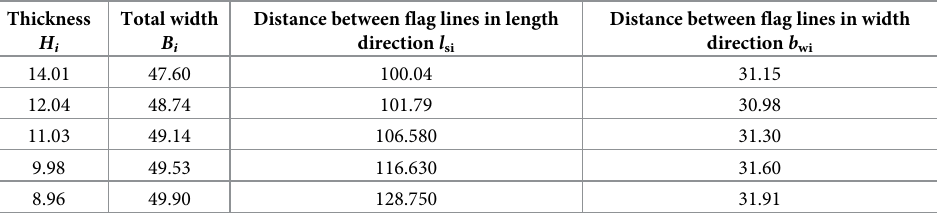
Table 1. Original data of the flat rolling experiments of the CORFT (mm).